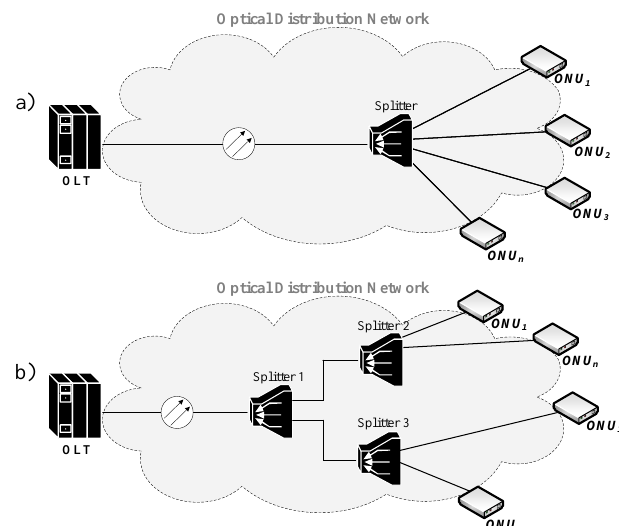
Figure 1. Basic passive optical network (PON) structure ( a ) according to standards, ( b ) most common PON structure in real networks.